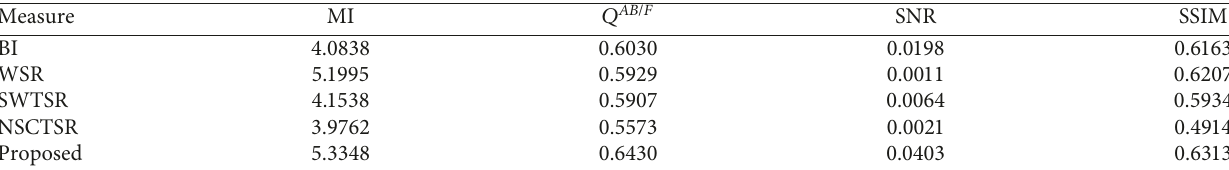
Table 6: Various super-resolution measurement